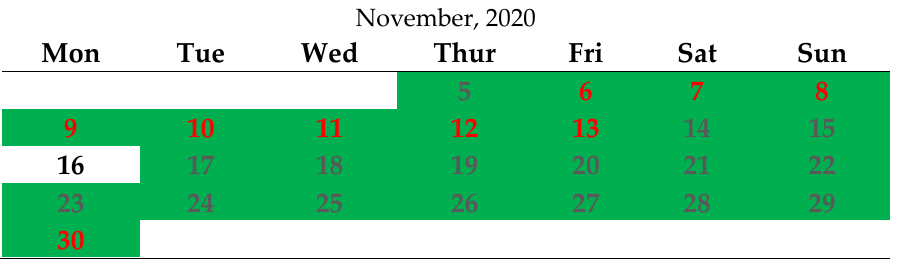
Figure 6. Experimental weather conditions (Note: Data were collected for 25 days from 5 to 30 November 2020 except 16 November 2020. Among them, red font color represents sunny weather, totaling 9 days; grey font color represents cloudy weather, totaling 16 days; and black font color represents rainy weather, totaling 1 day).